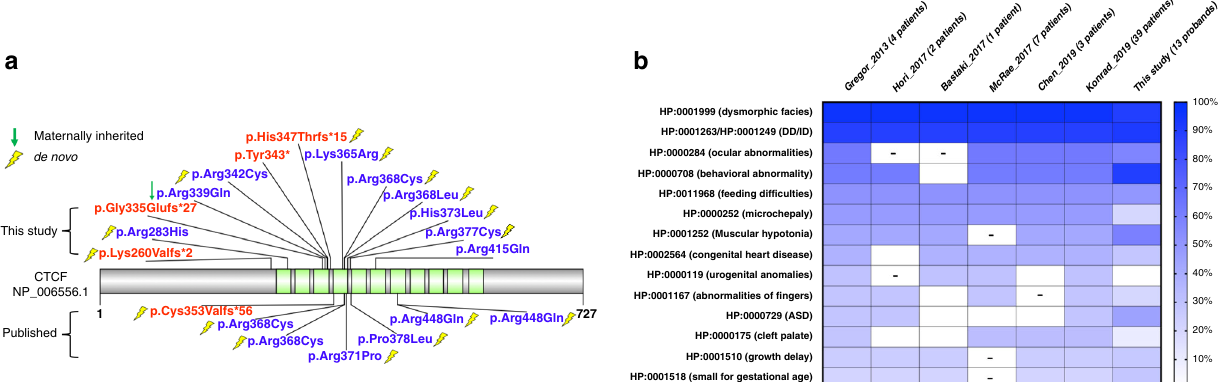
Fig. 3 Severe variants and the genotype – phenotype correlations in CTCF . a LGD (red) and MIS30 (blue) variants are depicted against a protein model for CTCF . Variants new to this study are shown above the protein while published DNMs from denovo-db (v1.5) are below. Variants are fl agged with yellow lightning bolt if de novo. Annotated protein domains are shown (colored blocks) for the largest protein isoforms. b Heatmap depicts the common clinical features for patients carrying CTCF severe variants by using the speci fi c HPO annotation (rows), which were retrieved from published studies and our cohort (columns). Phenotypic enrichment is shown according to the features ’ recurrence labeled by the increment of color degree. The items with no data available were labeled with “ - ” and were excluded in the frequency analysis.